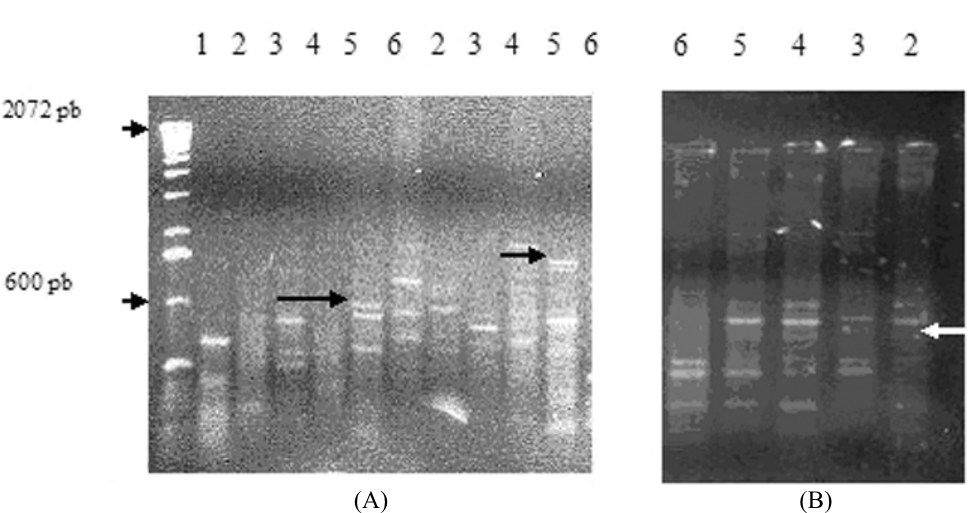
Fig. 4 – Products amplified by primers of RAPD (OPA3, OPA2 and OPA7, respectively). (A) 1 – marker (100 pb); 2 – Goiás; 3 – Minas Gerais; 4 – Porto Nacional; 5 – São José do Xingu (populations with thorn); 6 – São José do Xingu (populations without thorn) showing polymorphism in the pequi without thorns (black arrows). (B) Monomorphism in the pequi with thorn and absence of the band detected in the pequi without thorn (blank arrow). Agarose gel 2% colored with Ethidium Bromide.